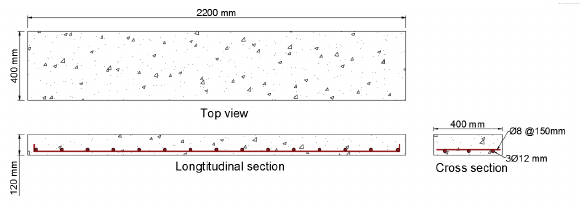
Figure 1: Dimensions and details of specimens OWS1.